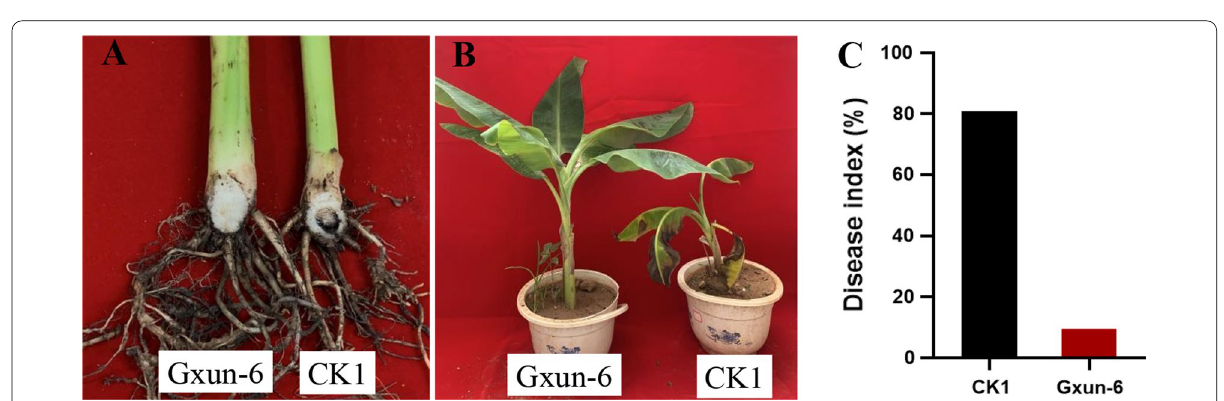
Fig. 8 A Browning of banana seedling bulb profile. B Pot control effect of strain Gxun-6 on FOC TR4. C Disease